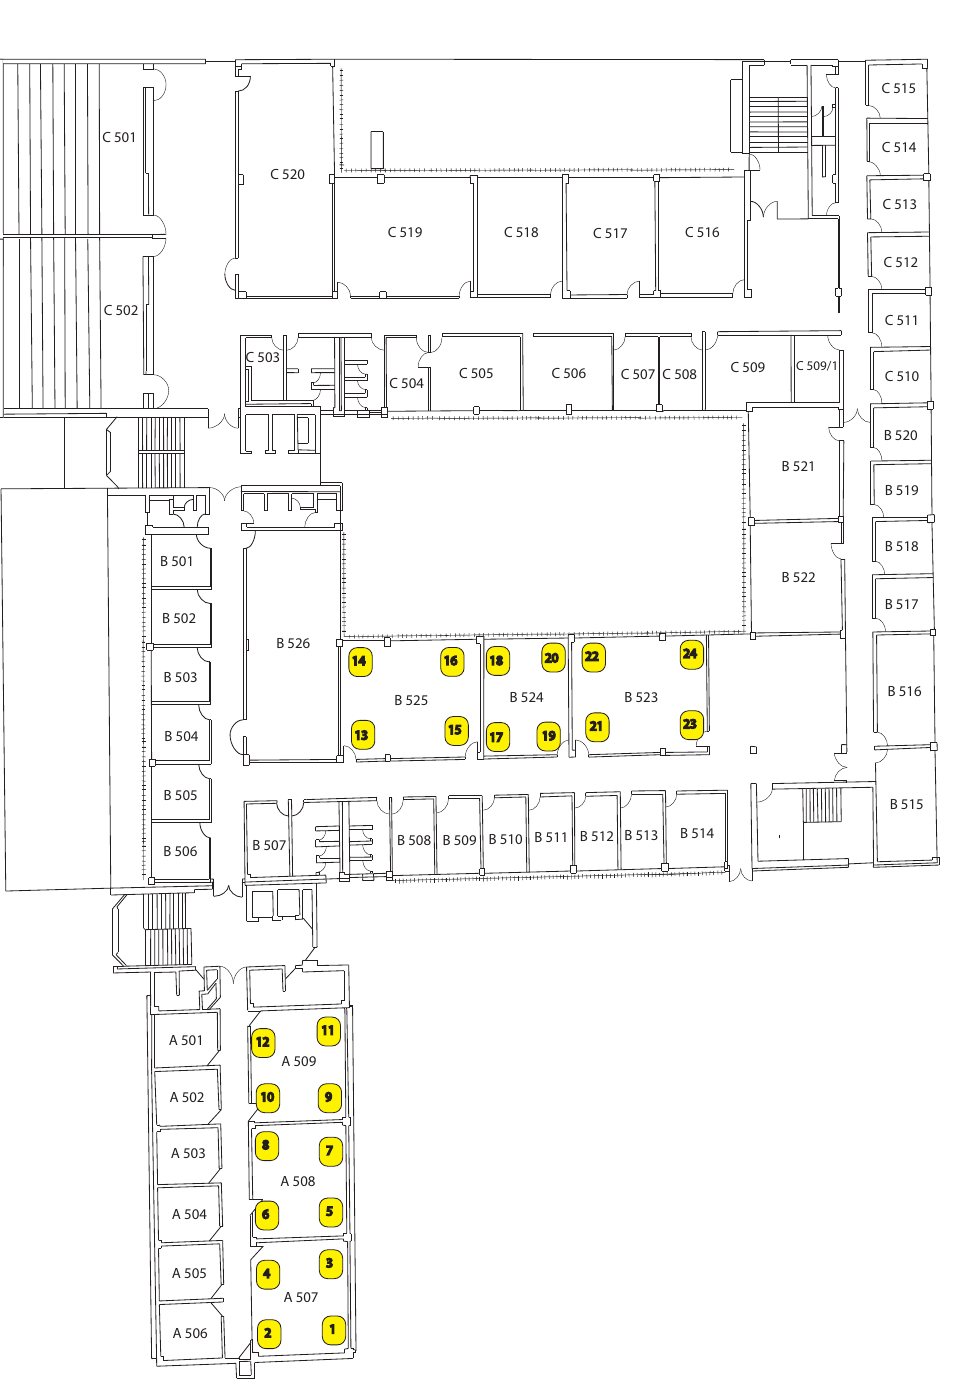
Figure 5. Measurement